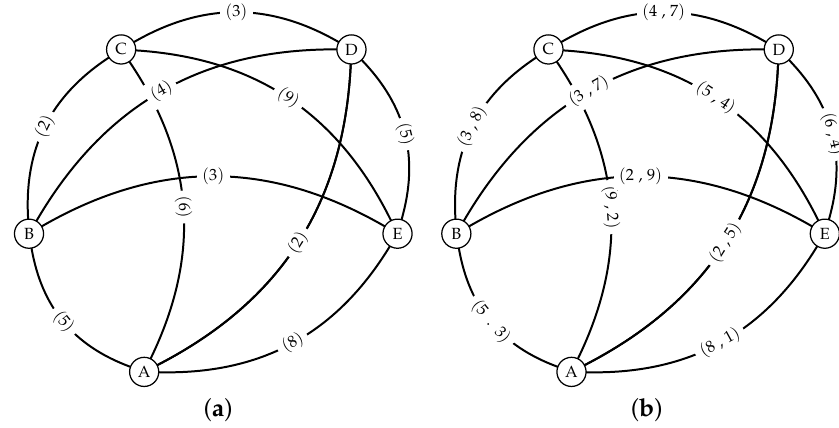
Figure 1. Illustration of single and bi-objective TSP graphs. ( a ) A graph with weights (distances) on its edges as a single-objective optimization problem. ( b ) A graph with weights (distances and times) on its edges as a bi-objective optimization